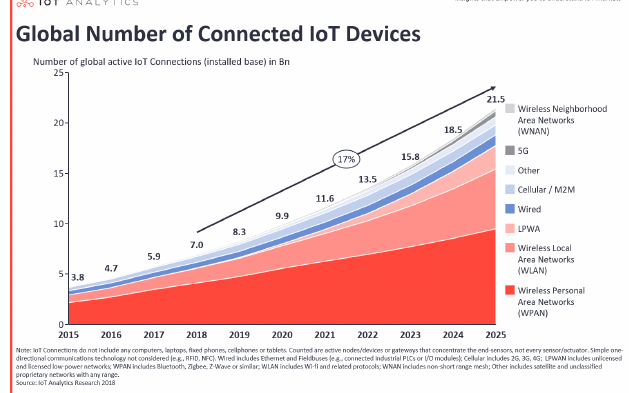
Figure 1. Expected Number of IoT devices by 2025, Source: IoT- Analytics